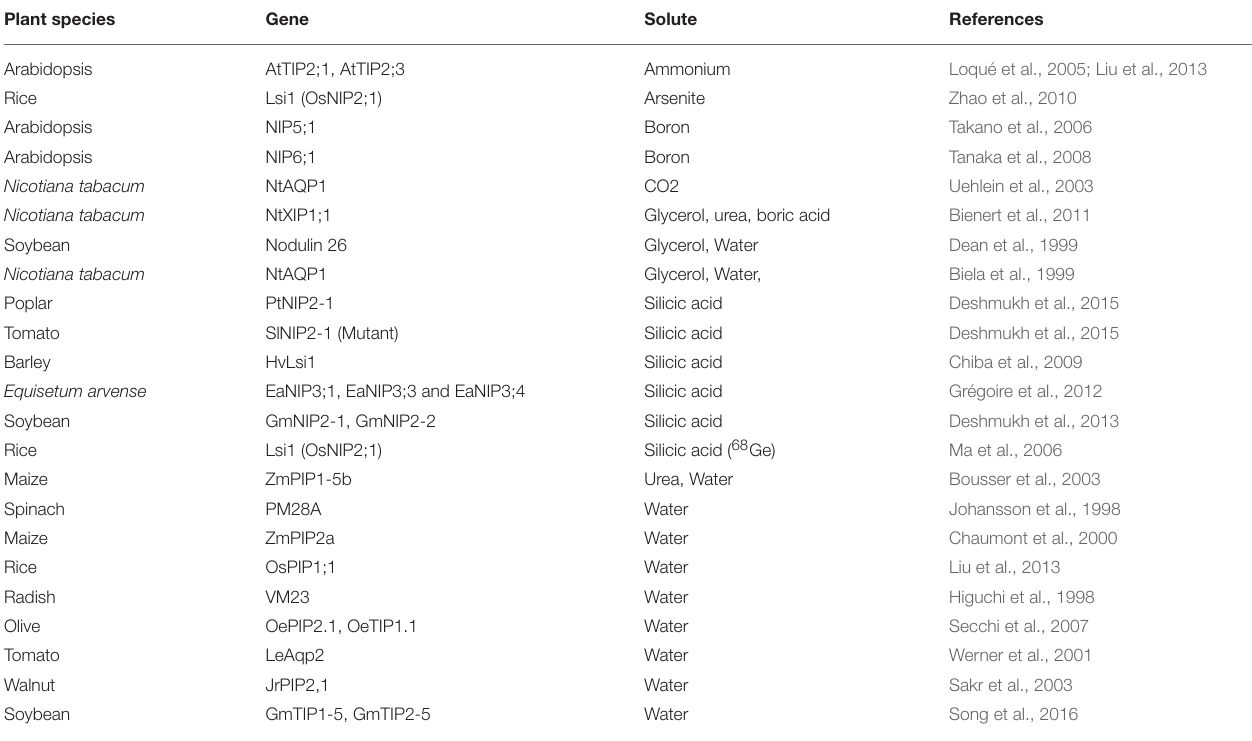
TABLE 3 | List of important studies performed to evaluate different solutes transported by plant aquaporins using the Xenopus oocyte assay. Plant